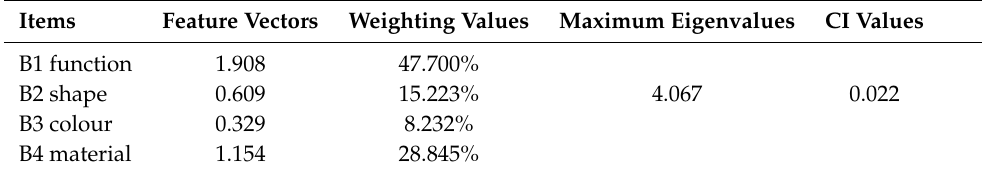
Table 1. AHP Hierarchical Analysis Results.